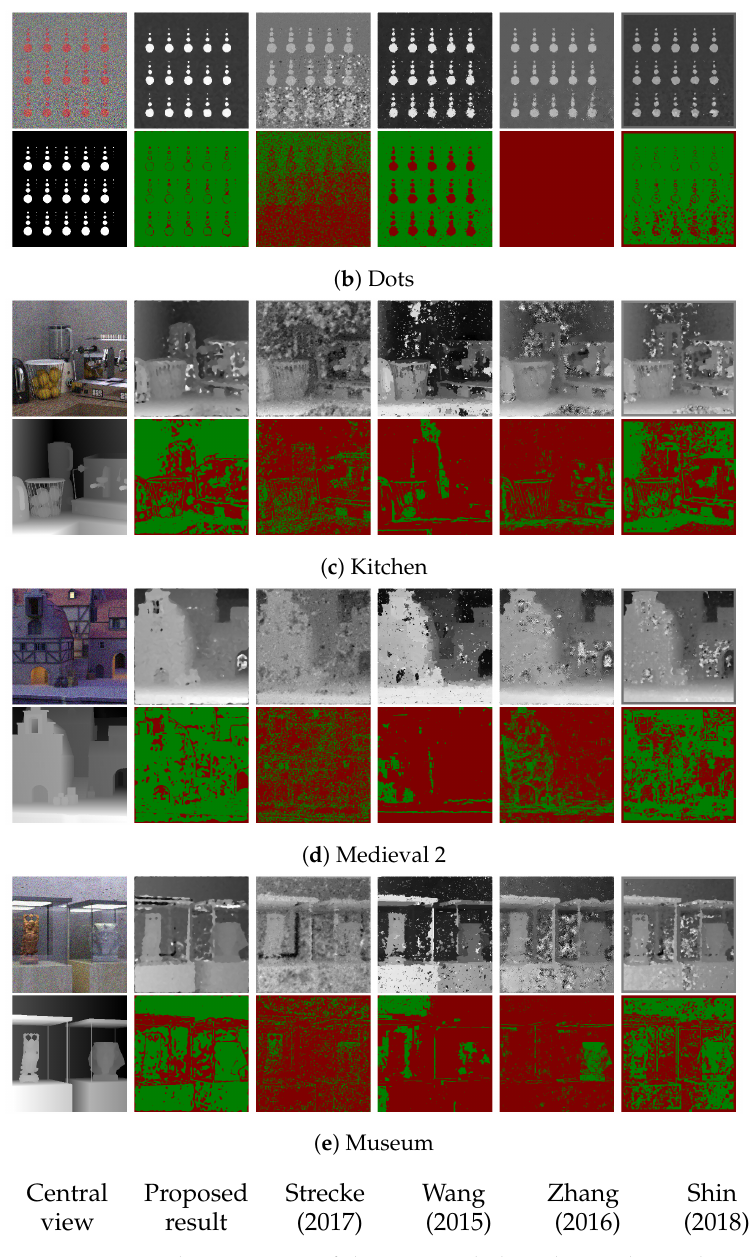
Figure 24. Visual comparison of the proposed algorithm with Strecke et al. [9], Wang et al. [10], Zhang et al. [11] and Shin et al. [12] for synthetic LF images with added noise.